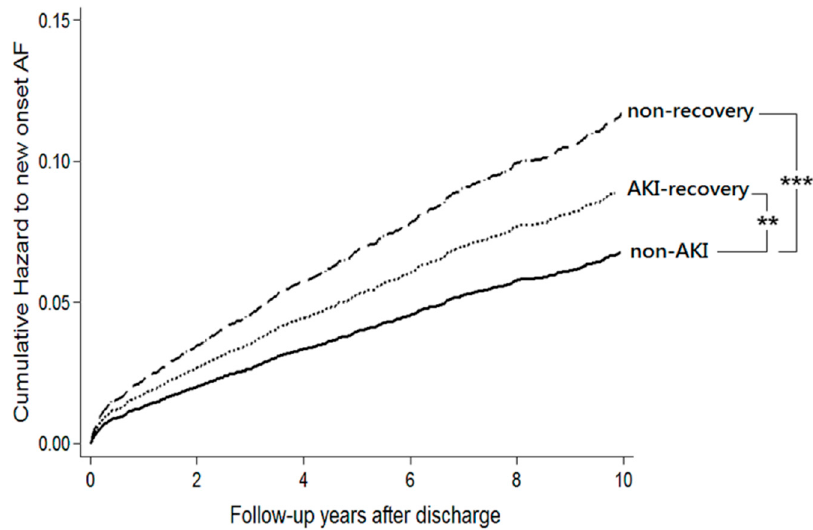
Figure 2. Cumulative incidences of atrial fibrillation among the three groups. Note: The analysis was performed using the Cox proportional hazard method with adjustment to the Charlson Comorbidity Index, age, gender and advanced chronic kidney disease (time-varying covariate). *** denotes p < 0.001, ** denotes p < 0.01. Abbreviations: AF, atrial fibrillation; AKI, acute kidney injury.